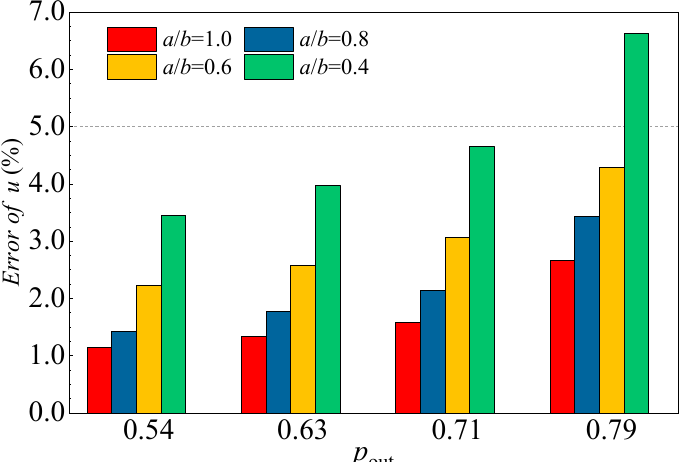
Figure 14. The error of injection ratio under different bypass backpressures.